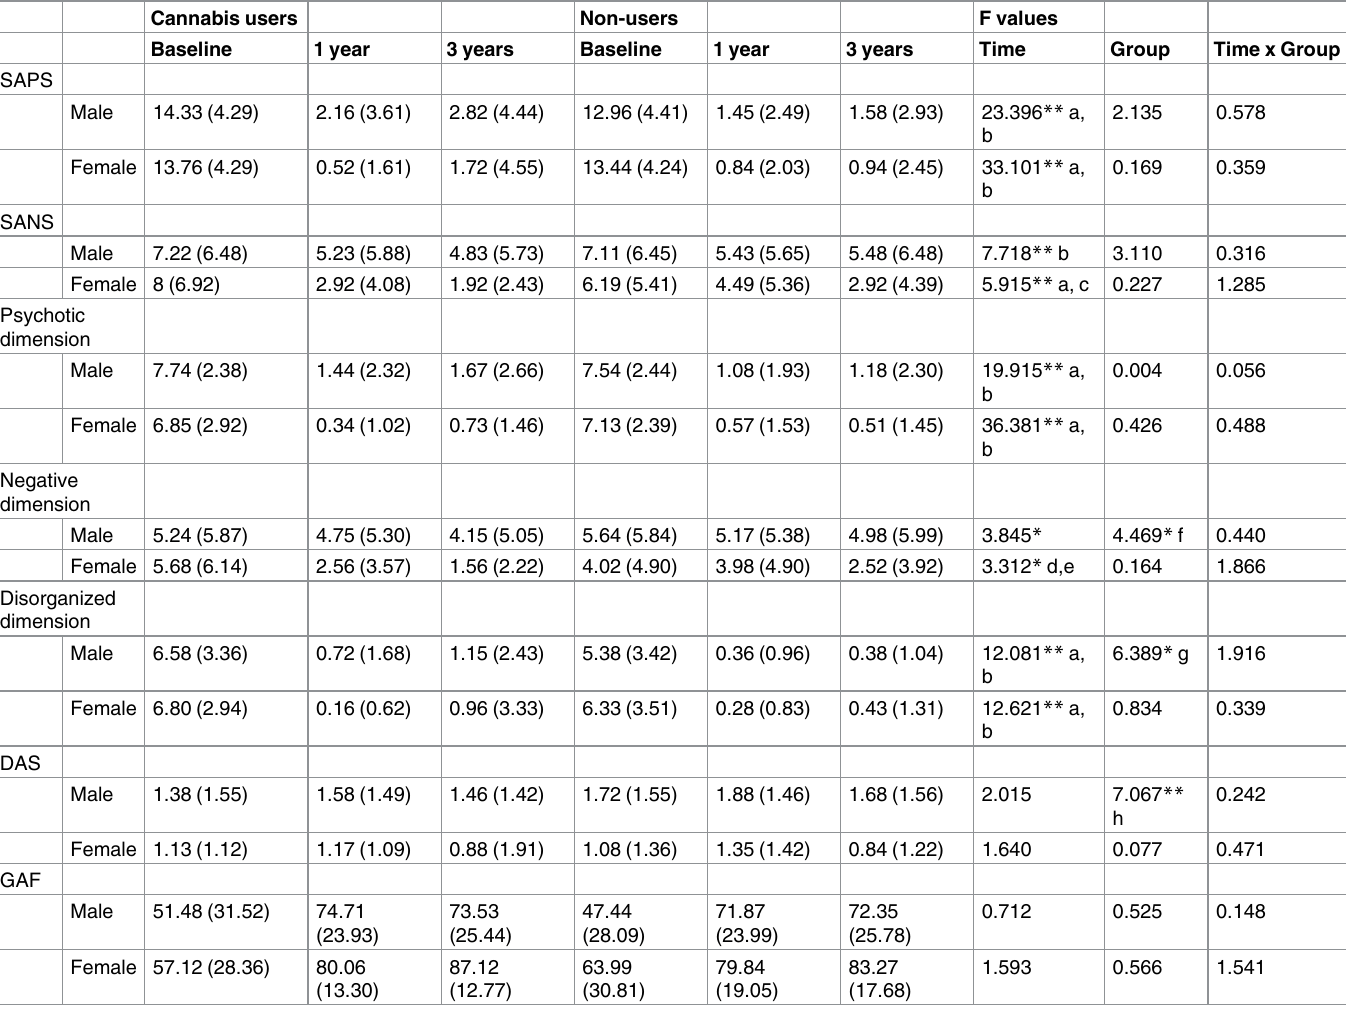
Table 2. Change in function and symptoms over